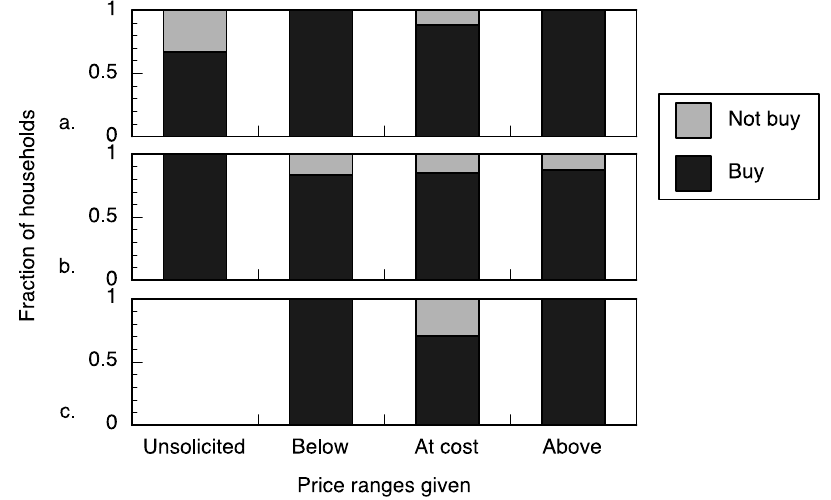
Figure 11. Responses to the question, “how much would you pay for this technology?” (willingness-to-pay) with three prices given, in descending order, or “would not purchase” in the vernacular at communities ( a ) A, ( b ) B, and ( c ) C. Any responses to price were aggregated as “buy” and negative responses were recorded as “not buy”. The three ranges based on the cost of production of the product: below cost, at cost, and above cost. Houses were randomly assigned which range of prices would be asked and each range included three prices. The figure shows a willingness to pay in the above-cost range in all communities.